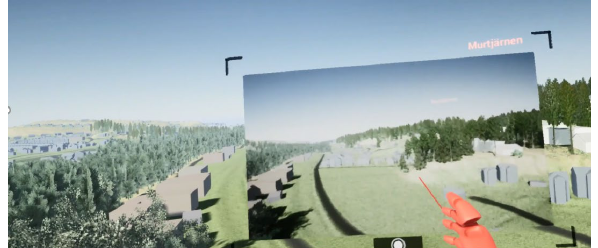
Figure 9 . One of the interactive functionalities in the VR